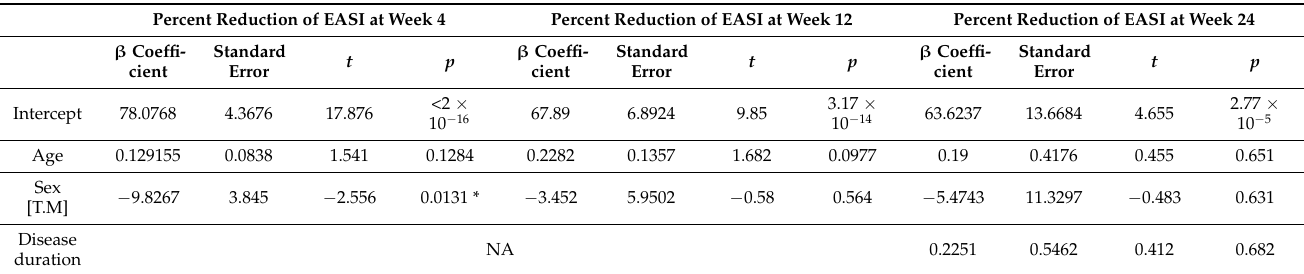
Table 5. The predictive factors for the percent reduction of eczema area and severity index (EASI) at weeks 4, 12, or 24 of upadacitinib treatment assessed by linear multivariate regression analysis in patients with atopic dermatitis ( n = 65).